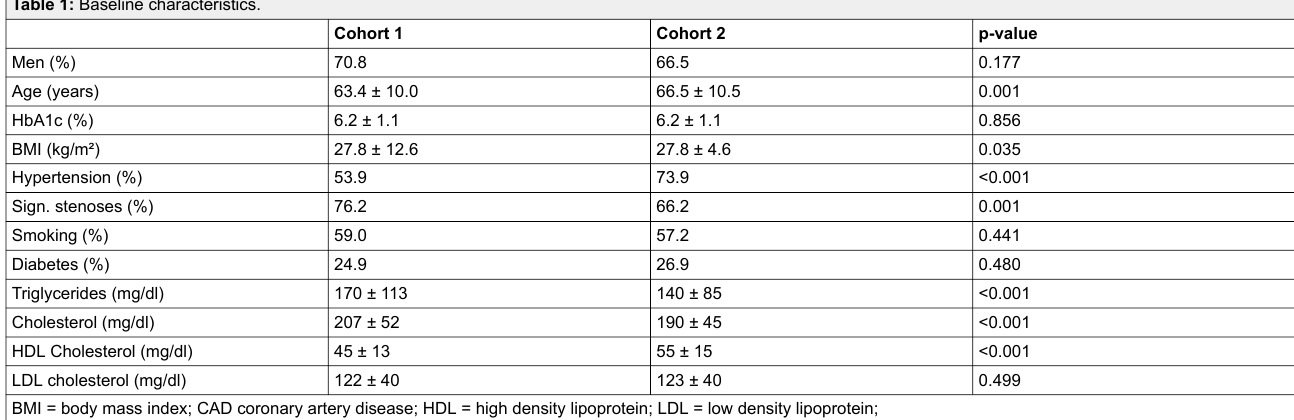
Table 1: Baseline characteristics.